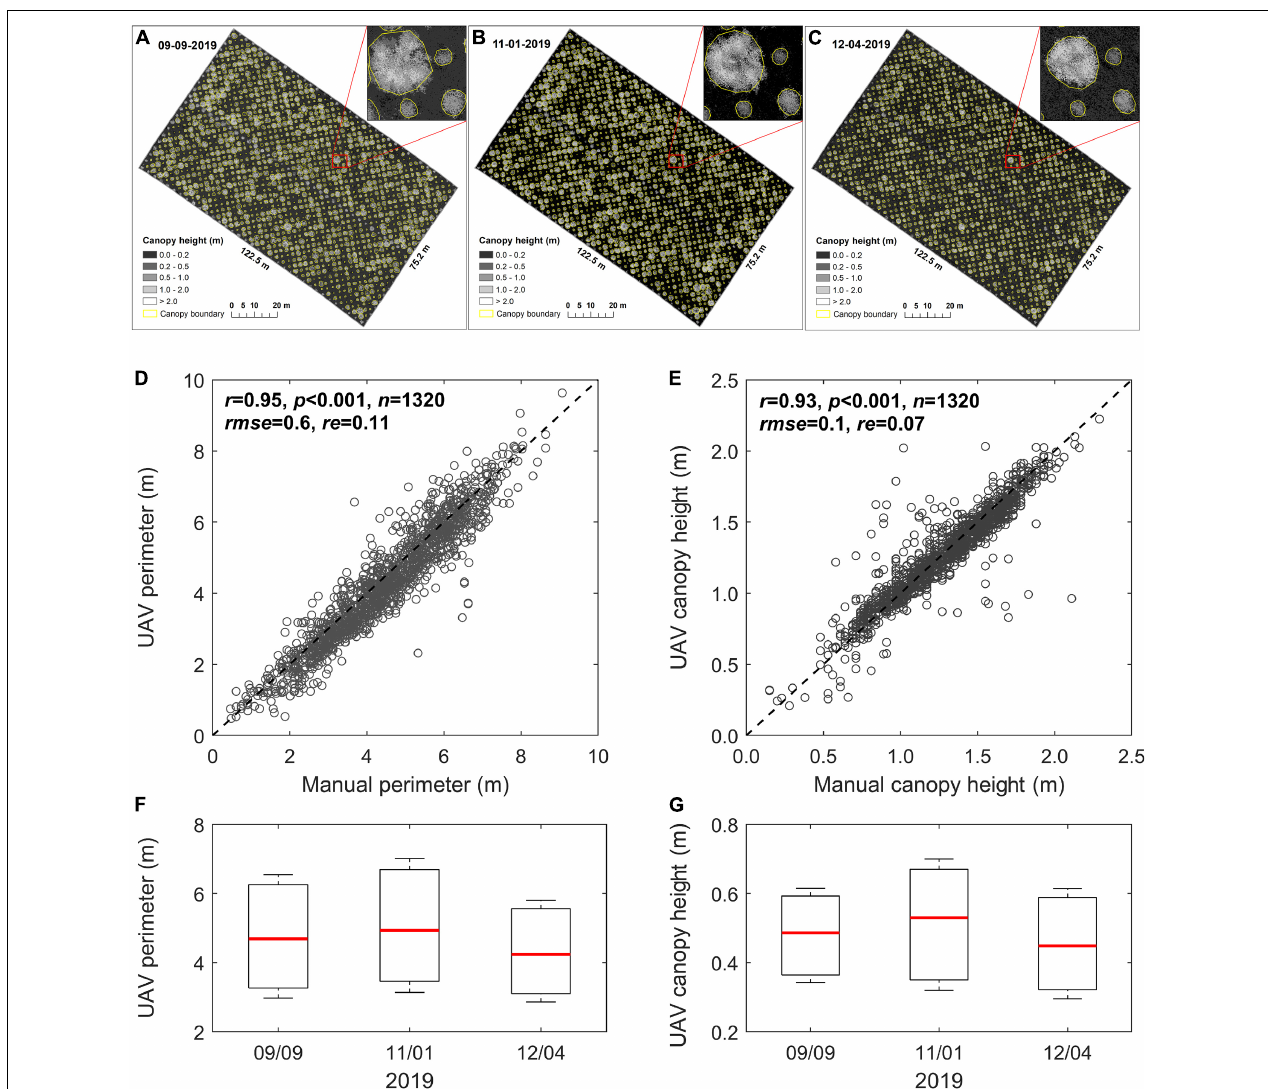
FIGURE 5 | Changes in UAV-based plant phenotyping parameters and validation. (A–C) Spatiotemporal changes in plant canopy perimeter and height based on UAV measurements during the growing season; (D,E) validation of the UAV-based plant perimeter and height with manual measurements for a total of 1,320 plants, where plant canopy height was compared based on the top of the central panicles. The UAV and manual measurements were collected on December 4, 2019; (F) and (G) boxplots of the changes in plant perimeter and height, respectively, from peak season to the end of the season, where the red line on the box indicates the median, and the bottom and top edges of the box indicate the 25 th and 75 th percentiles,